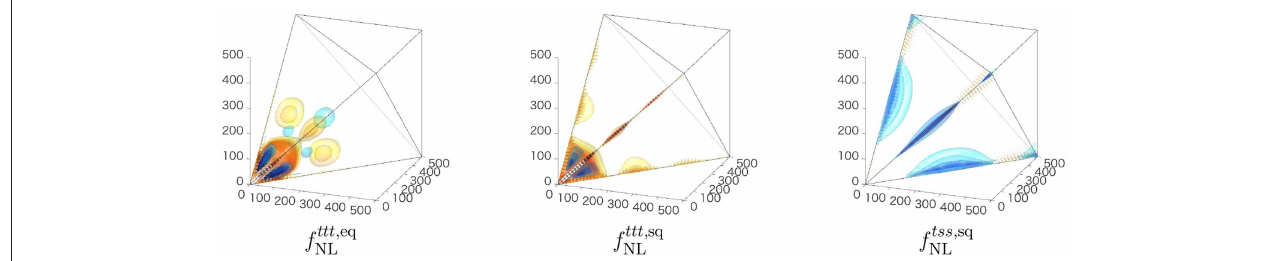
FIGURE 1 | Intensity distributions of the CMB temperature bispectra from the axion model f ttt ,eq NL template (3), the PMF model f ttt ,sq NL one (8), and the massive gravity model f tss ,sq NL one (16) in the ℓ -space tetrahedral domain where the axes correspond to ℓ 1 , ℓ 2 , and ℓ 3 , respectively. Here, the bispectra are rescaled using a constant Sachs-Wolfe template (Fergusson et al., 2010). Dense red (blue) color expresses a larger positive (negative) signal. The current and future observational limits on f ttt ,eq NL , f ttt ,sq NL , and f tss ,sq NL are discussed in sections 4.2 and 4.3,